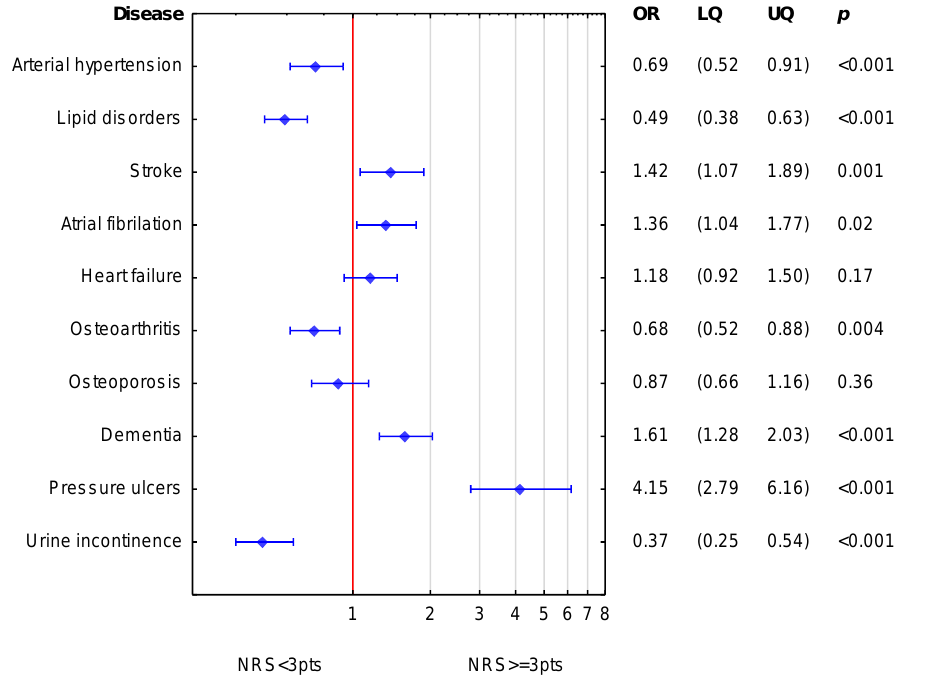
Figure 1. Simultaneous association of diseases accompanying NRS-2002 for the whole group of patients. (OR—odds ratio; LQ—lower quartile; UQ—upper quartile; p — p value). Reference value (OR = 1; red line) corresponds to the absence of particular disease. Blue symbols correspond to odds ratios and 25–75% confidence intervals for the presence of particular disease.